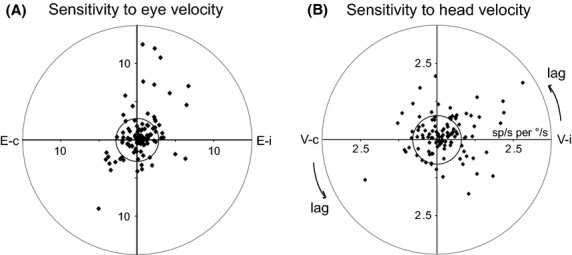
Sensitivity of Purkinje cells to eye and head velocity. Summary of the sensitivity of 110 Purkinje cells to eye velocity (A) and to head velocity (B), in polar coordinates. Distance from the origin represents the amplitude of eye or head velocity sensitivity, in spikes/s per °/s; the angle represents the phase of peak sensitivity, with a phase of 0° indicating peak firing during peak ipsiversive eye or head velocity. Counterclockwise rotation represents increased phase lag. Cells that responded to ipsiversive eye movements with an increase in firing rate were classified as Eye-ipsiversive (E-i; right quadrants in A) and cells that responded to ipsiversive head movements with an increase in firing rate were classified as vestibular-ipsiversive (V-i; right quadrants in B). Such responses are sometimes described as “type I.” Cells that responded to contraversive eye or head movement with an increase in firing rate were classified as E-c or V-c, or “type II.” Inner circles represent the mean sensitivity across the population. Note the different scales in panel A versus B.